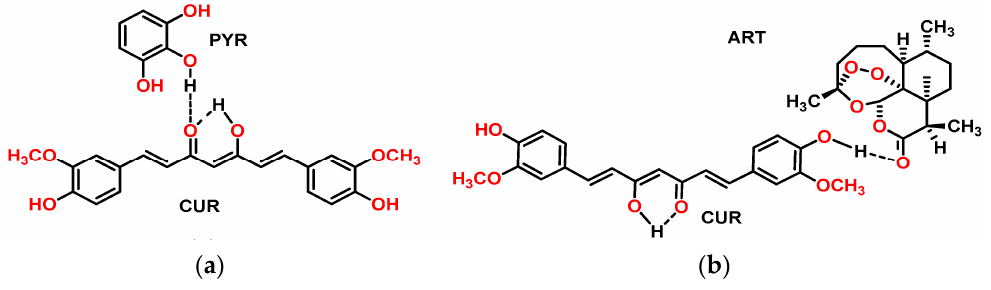
Scheme 1. The structure of Curcumin-Pyrogallol (CUR-PYR) cocrystal ( a ) and Curcumin-Artemisinin (CUR-ART) co-amorphous ( b ) are stabilized through intermolecular O–H···O hydrogen bonding.